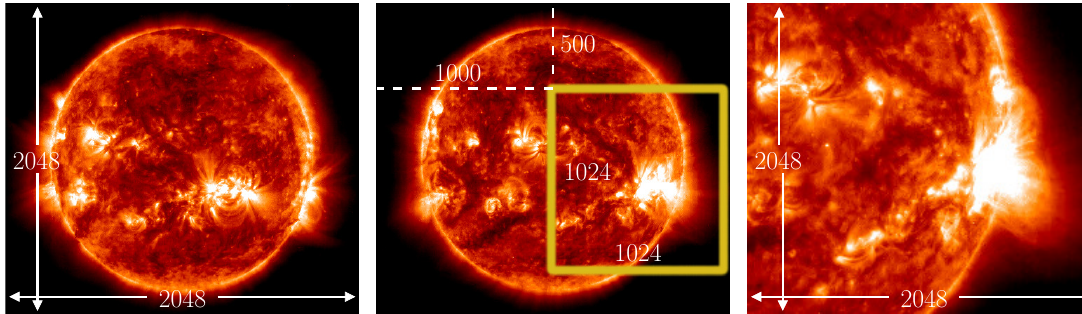
Figure 1. Different instants of a remote browsing (on a 2048 2048 pixels display) of a × 4096 4096 pixels image sequence of extreme ultraviolet images of the Sun, taken by NASA’s Solar × Dynamics Observatory (SDO), using the JHelioviewer application. Initially, users retrieve the sequence of images with a resolution that fits in their display (left subfigure). Notice that the information of the highest spatial resolution level (4096 4096) is not transmitted because can not be displayed. In any × moment of the transmission users can select a Window Of Interest (WOI), which in this example starts at pixel 1000 500 and have a (image) resolution of 1024 1024 (center subfigure), retrieving this WOI × × at the highest resolution. In the rest of the transmission (right subfigure), only the code-stream related to that WOI will be transmitted. Image credit: NASA/SDO/AIA.